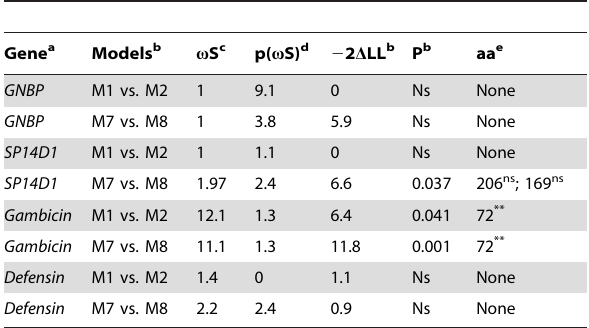
Table 6. Positive selection on single codon level based on PAML (see text for